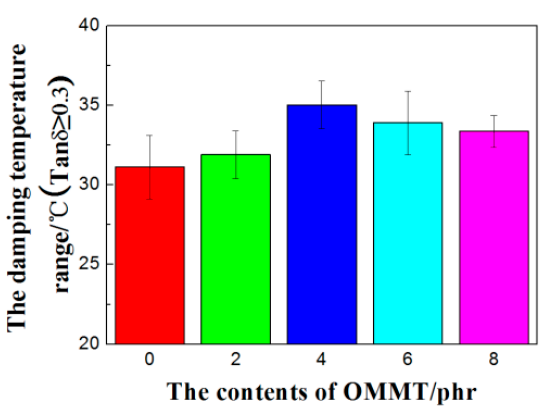
Figure 7. Comparison the damping temperature of CB/NR with different contents of OMMT.